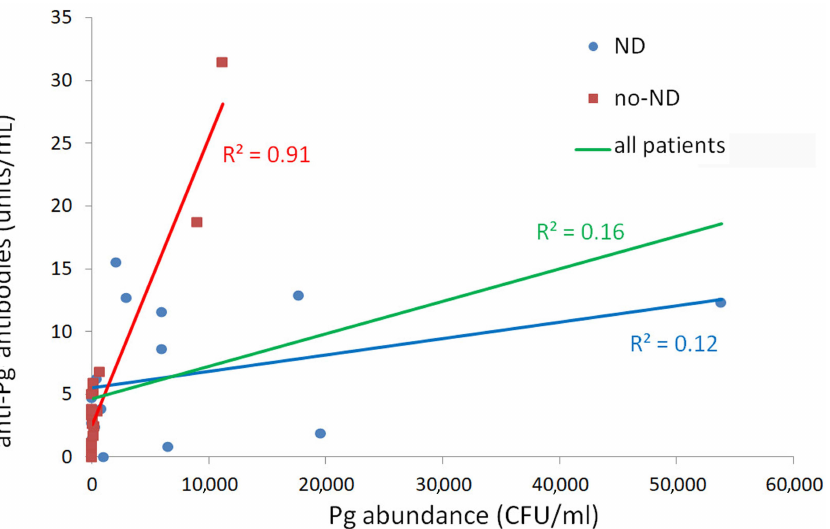
Figure 1. Relationship between anti-Pg antibodies and Pg abundance in all patients. Data were fitted with lines for ND, no-ND, and all